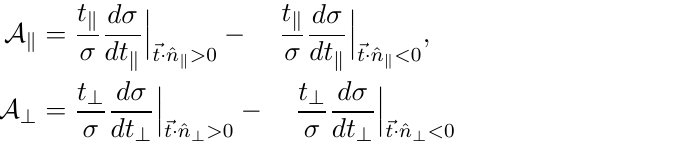
Figure 5 . Monte-Carlo simulations of the ~t (cid:1) ^ n measured on H ! b (cid:22) b events generated with Pythia v8.240. The plots show results at both parton and hadron